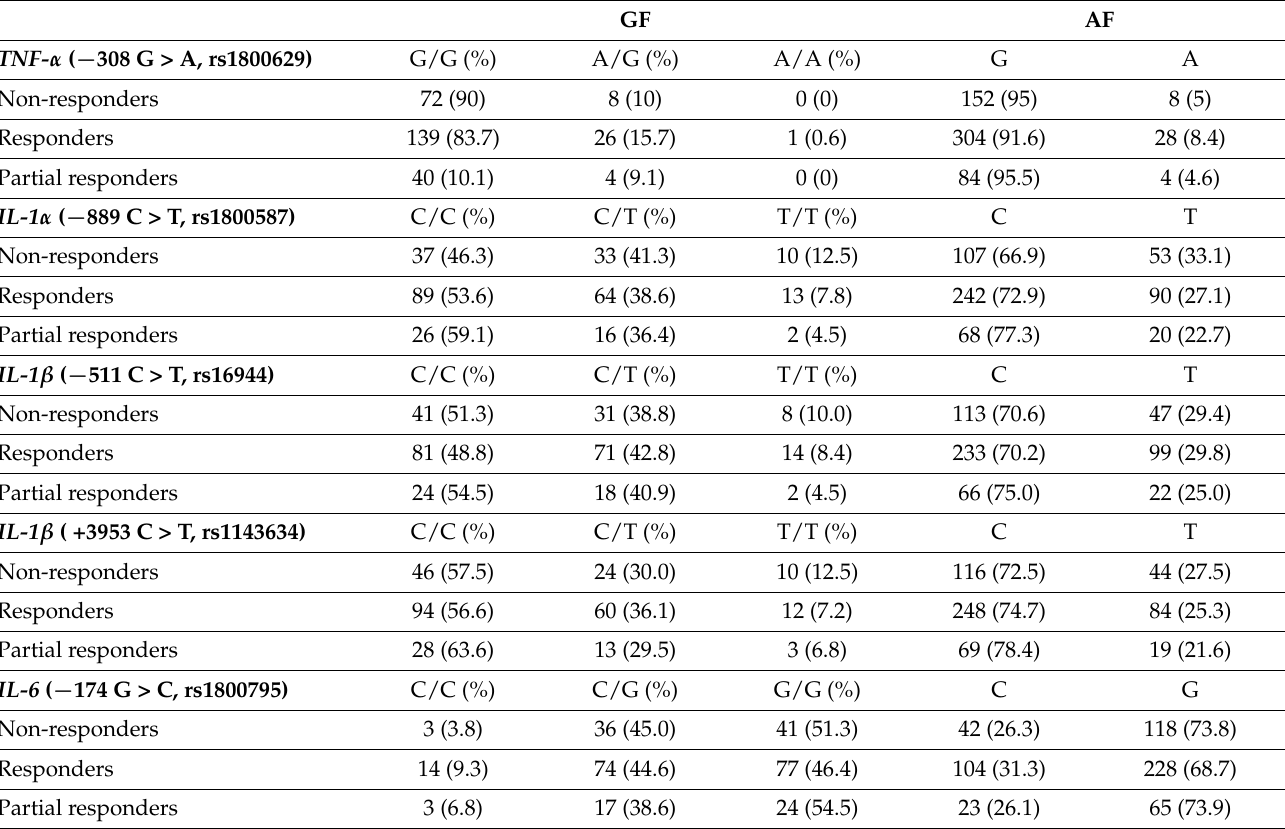
Table 3. Genotype frequencies (GF) and allele frequency (AF) of polymorphisms of TNF- α ( − 308 G > A, rs1800629), IL-1 α ( − 889 C > T, rs1800587), IL-1 β ( − 511 C > T, rs16944 and +3953 C > T, rs1143634), IL-6 ( − 174 G > C, rs1800795), in non-responders, responders and partial responders to triptans. Data are displayed as count and